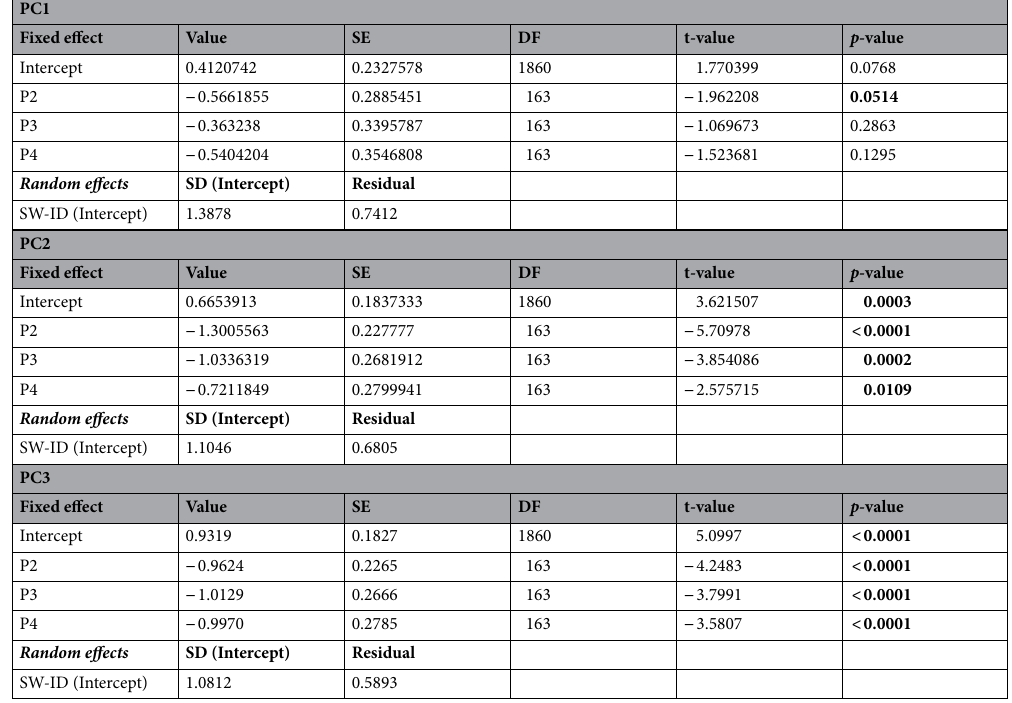
Table 4. Generalized linear mixed-effect model (GLMM) with ‘population demography’ as explanatory variable on PC1, PC2 and PC3. The upper section shows the significant effects of the assessed explanatory variables. Value, standard errors (SE), t-values, and significance level ( p -value) for variables retained in the model are provided for fixed effects (explanatory variables), while estimates of the standard deviations (SD) are reported for random effects (SW-ID). Significant level in